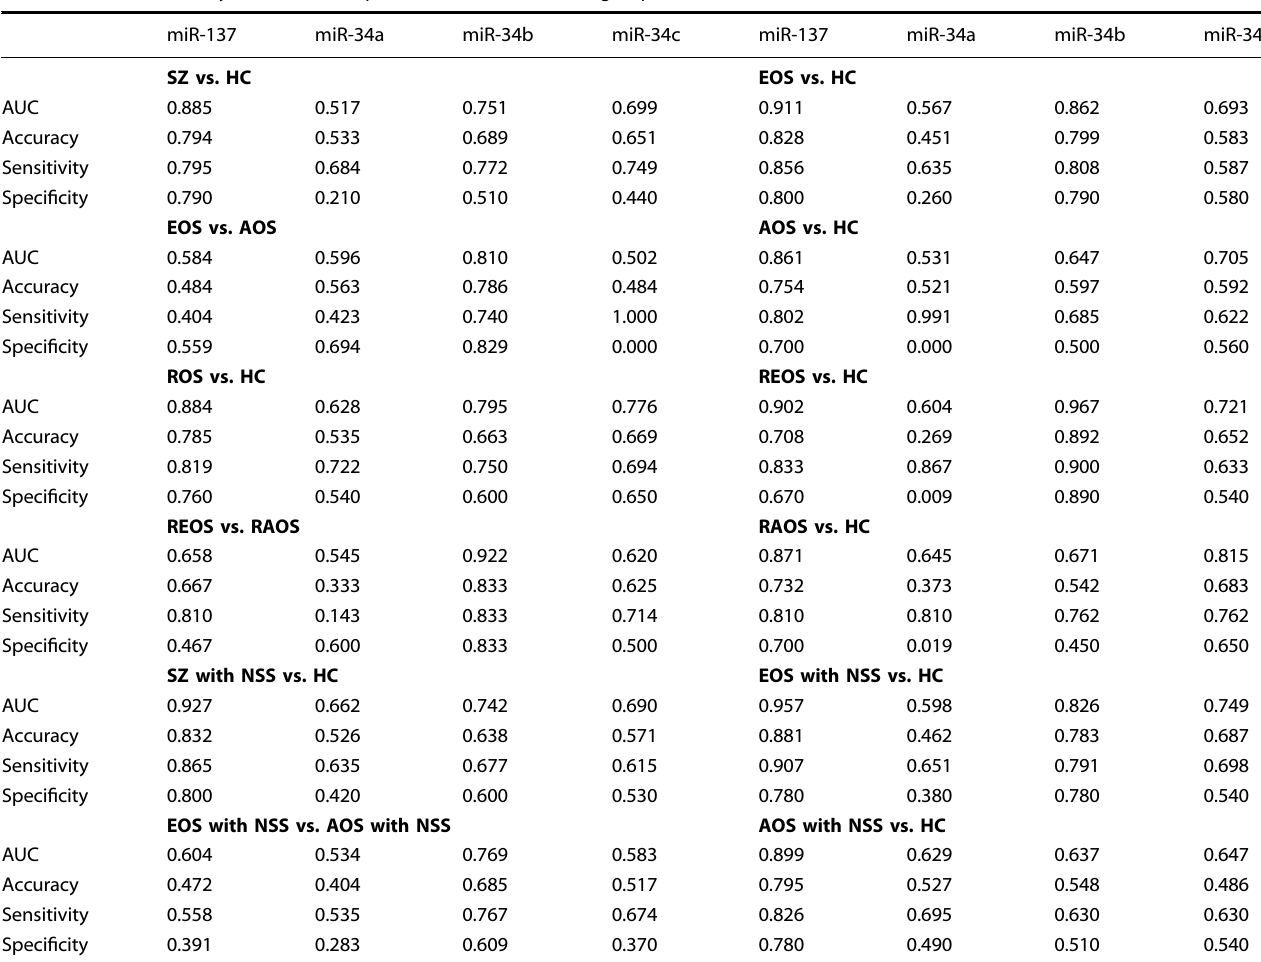
Table 2. ROC curve analysis of miRNA expression levels in different